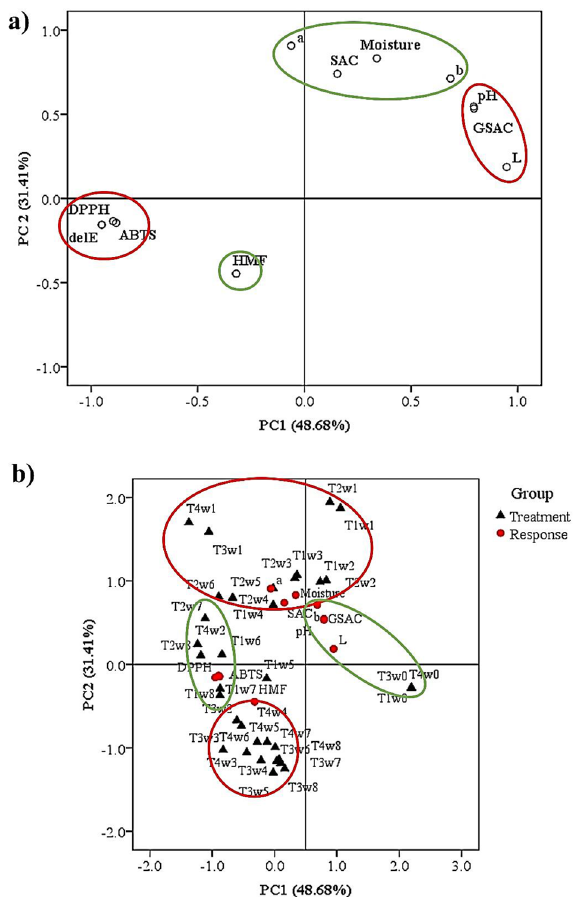
Figure 4. Principal component (PC) analysis of garlic qualities ( a ) and biplot analysis of garlic samples and their physiochemical properties ( b ); T1 = 60 °C and 65% RH, T2 = 60 °C and 80% RH, T3 = 80 °C and 65% RH, T4 = 80 °C and 80% RH and w0–w8 =